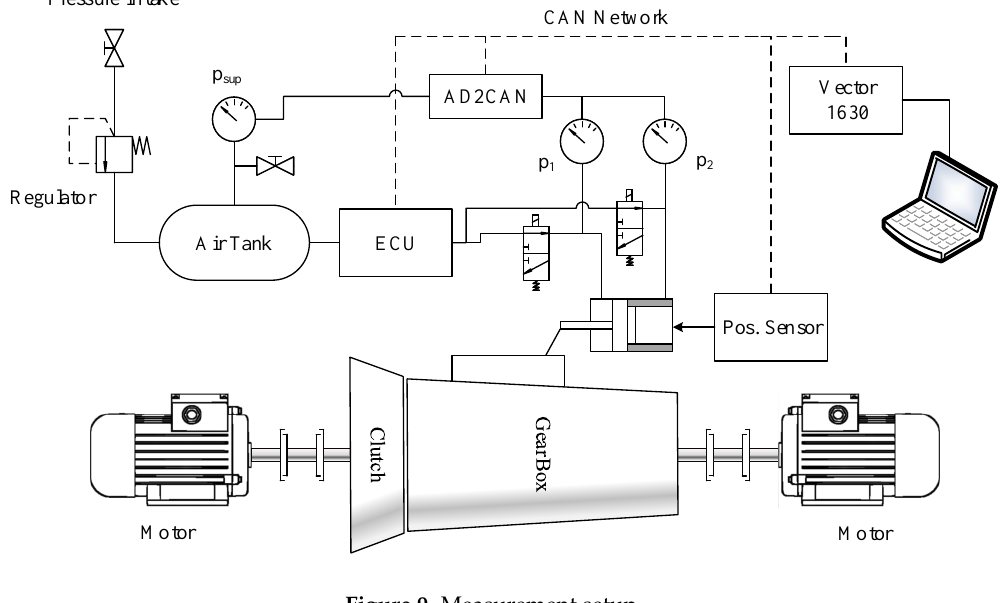
Figure 9. Measurement